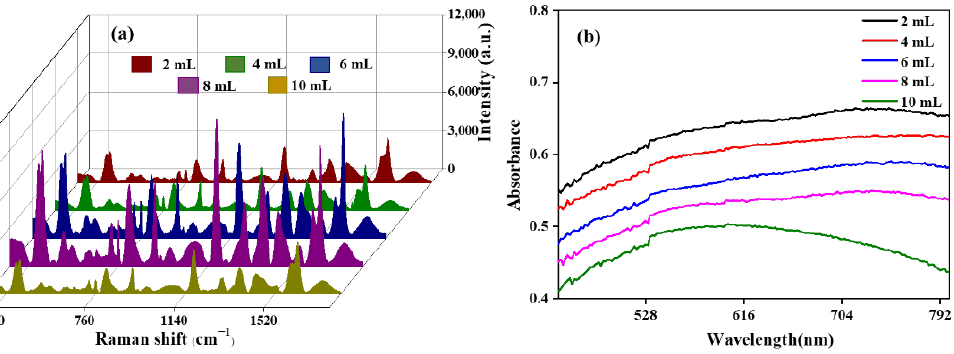
Figure 2. SERS effect of CV detected by 1 mL 2 mg/mL GO/Fe 3 O 4 @Au MNPs prepared with different volumes of colloidal gold ( a ) and UV-vis absorption spectrum ( b ).